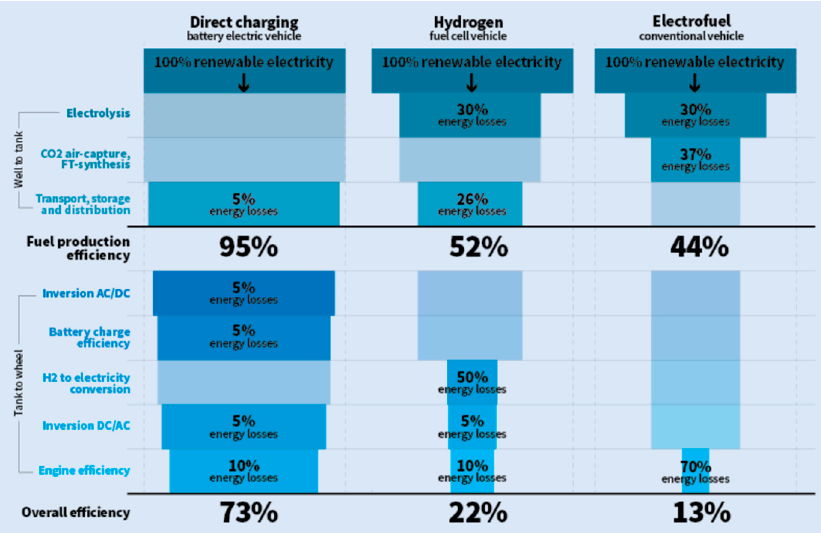
Figure 11. Vehicle overall (WTW) efficiency for electric, fuel cell and electrofuel burning in a IC engine (based on [87]).